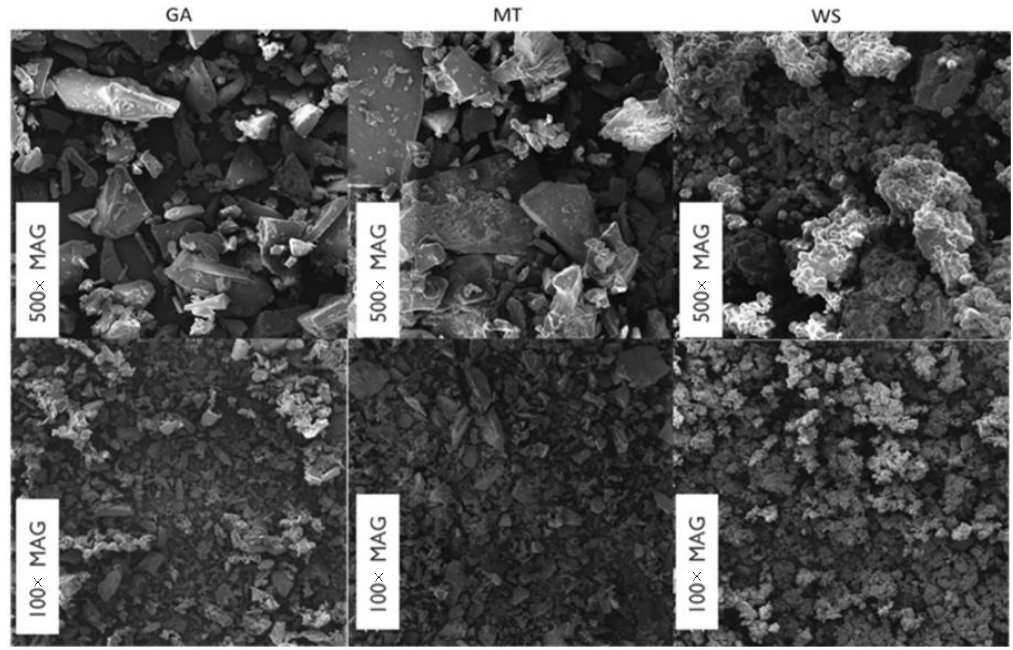
Figure 5. Scanning electron microscopy micrographs of freeze-dried raspberry juice powders devel- oped using different carrier agents. GA—gum Arabic; MT—maltodextrin; WS—waxy